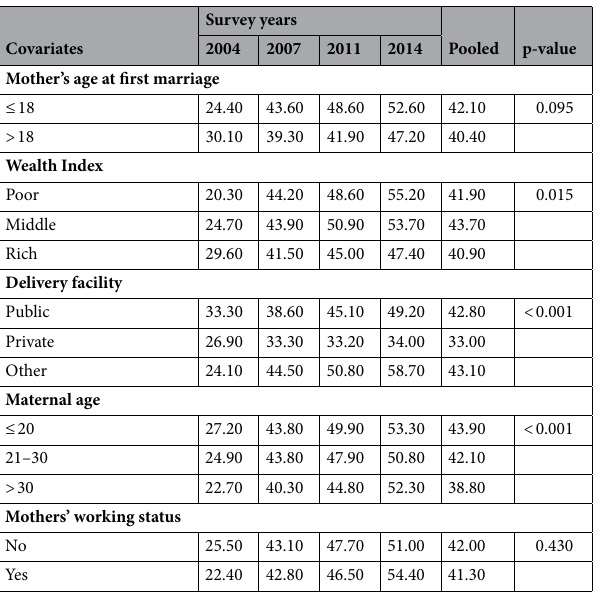
Table 1. Prevalence of EIBF in different years as well as for pooled data by different covariates, and p-values for the test of association between EIBF and different